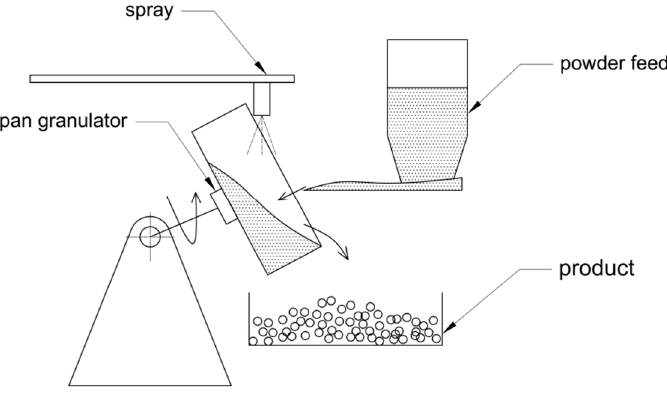
Figure 2. Schematic representation of the pan granulation process.